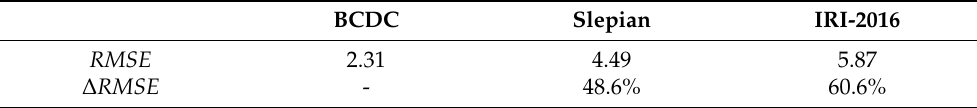
Figure 5. The RMSE (unit: TECU) of the STEC derived by the BCDC method, the Slepian method and the IRI − 2016 model at each moment by taking the STEC measurements of the cross-validation stations as the truths. Table 1. The RMSE (unit: TECU) and the ∆ RMSE of the STEC derived by the BCDC, the IRI-2016, and the Slepian method for all moments.